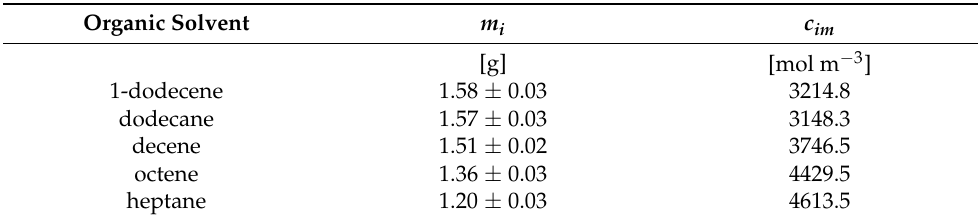
Table 3. Mass and concentration of organic solvent inside the oNF-3 membrane samples. Gravimetric absorption experiments were conducted with five individual membrane samples. Mean values and standard deviations are given.